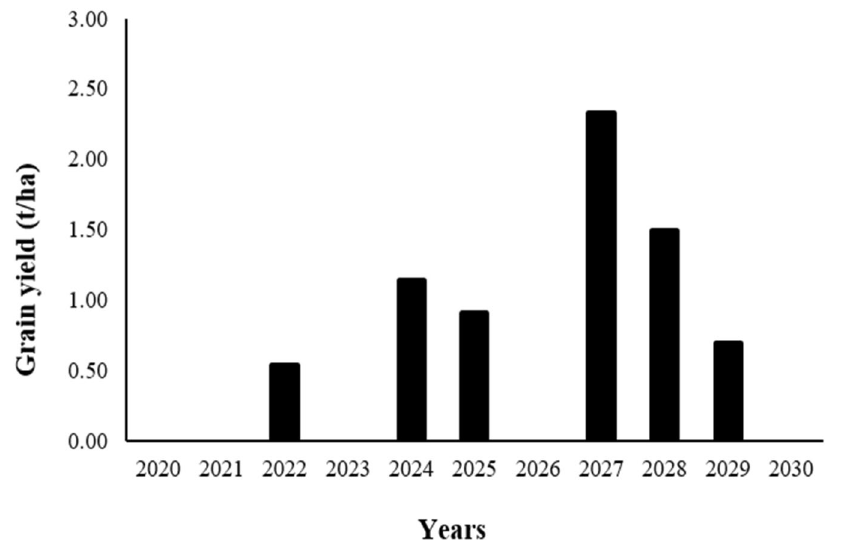
Figure 17. Future scenarios for wheat yield in the Rhamna